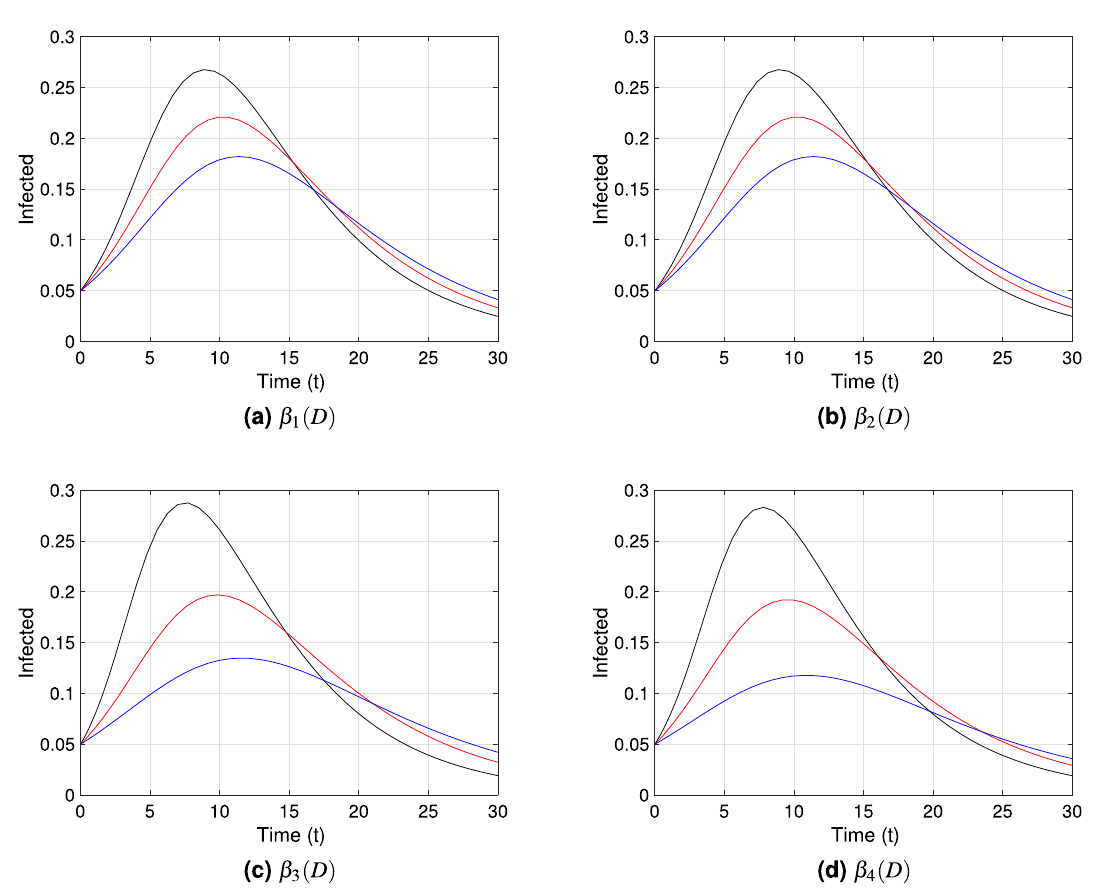
Figure 4. Point prevalence, I ( t )/ N , from the system in Eq. (1) with respect to time for each transmission functional form and ν = 1 . Black, red and blue curves correspond to D ∗ = 0.75 ( m ) , D ∗ = 1.05 ( m ) , and D ∗ = 1.35 ( m ) respectively. These correspond to societies of small ([0, 100)), medium ([100, 120]) and large ( [ 120, ∞ ) ) natural-distance types respectively (see Table 1). The other parameter values were taken to be β ∗ = 0.5 ; γ = 0.2 , ν = 1 , (cid:31) 1 = 0.03 , (cid:31) 2 = 0.3 . The R 0 value for each society are for ( a ) and ( b ): R 0 = 2.9 (black), R 0 = 2.5 (red), R 0 = 2.2 (blue); ( c ): R 0 = 3.5 (black), R 0 = 2.5 (red), R 0 = 1.9 (blue); ( d ): R 0 = 3.3 (black), R 0 = 2.5 (red), R 0 = 1.9 (blue). The initial condition D ( 0 ) = D ∗ was used for each type of